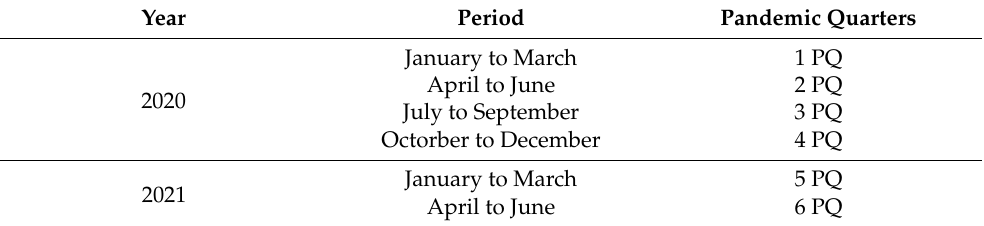
Table 1. Pandemic